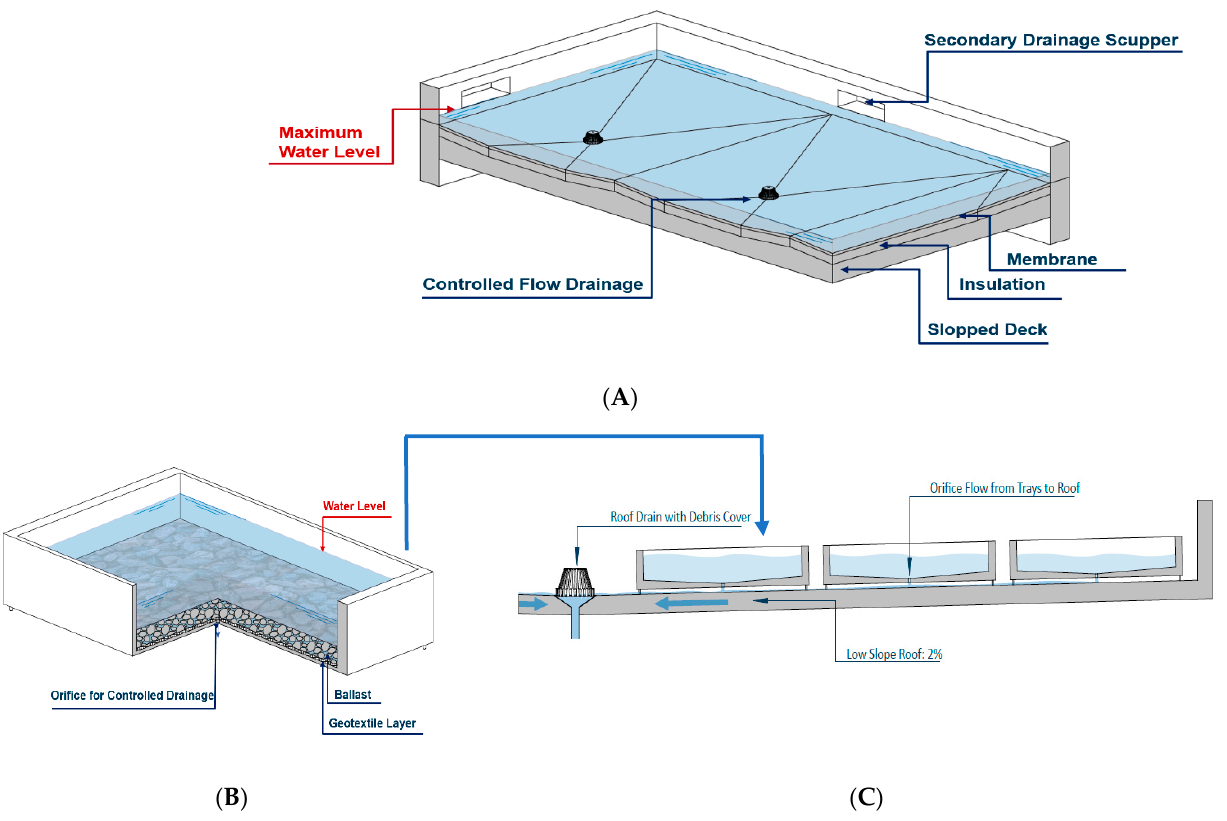
Figure 2. SDA types to detain storm ‐ water: ( A ) Roof ‐ Integrated Design (RID), ( B ) Modular Tray Design (MTD), ( C ) low ‐ sloped roof with MTD.